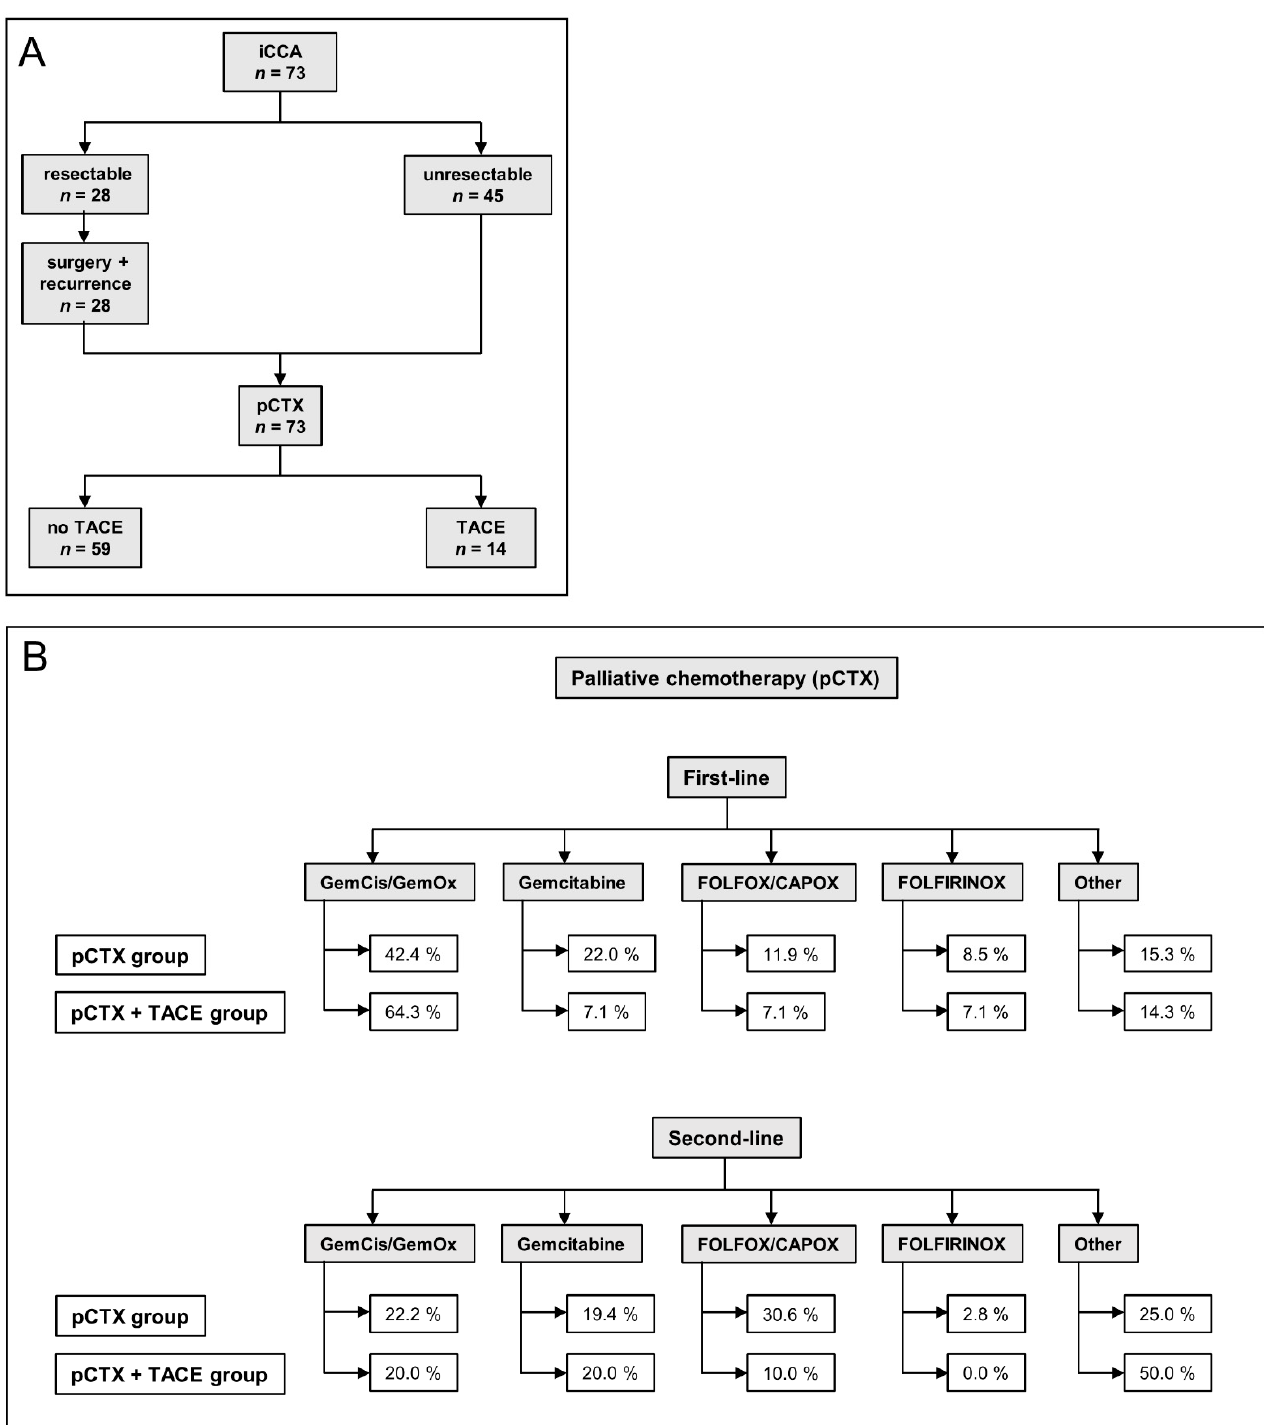
Figure 1. Treatment algorithm and chemotherapy regimens of the study patients. ( A ) Flow chart illustrating the treatment course of patients. iCCA: intrahepatic cholangiocarcinoma, pCTX: palliative chemotherapy, TACE: transarterial chemoembolization. ( B ) Flow chart indicating first- and second-line palliative chemotherapy (pCTX) of both groups. TACE: transarterial chemoembolization, GemCis: gemcitabine/cisplatin, GemOx: gemcitabine/oxaliplatin.